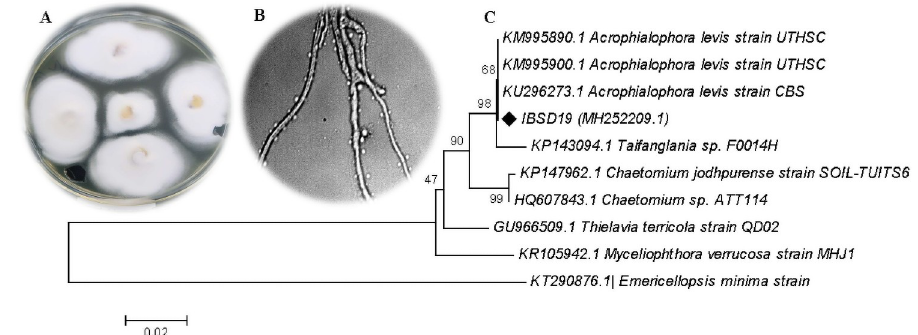
Fig 2. (A) Colonies of culture IBSD-19 grown on PDA for seven days, (B) image of conidia and conidiophores from a seven-day MEA culture, (C) phylogenetic tree of partial ITS-rDNA sequences of IBSD19 fungal strain. Reference sequences were downloaded from NCBI with the accession numbers indicated in parentheses.